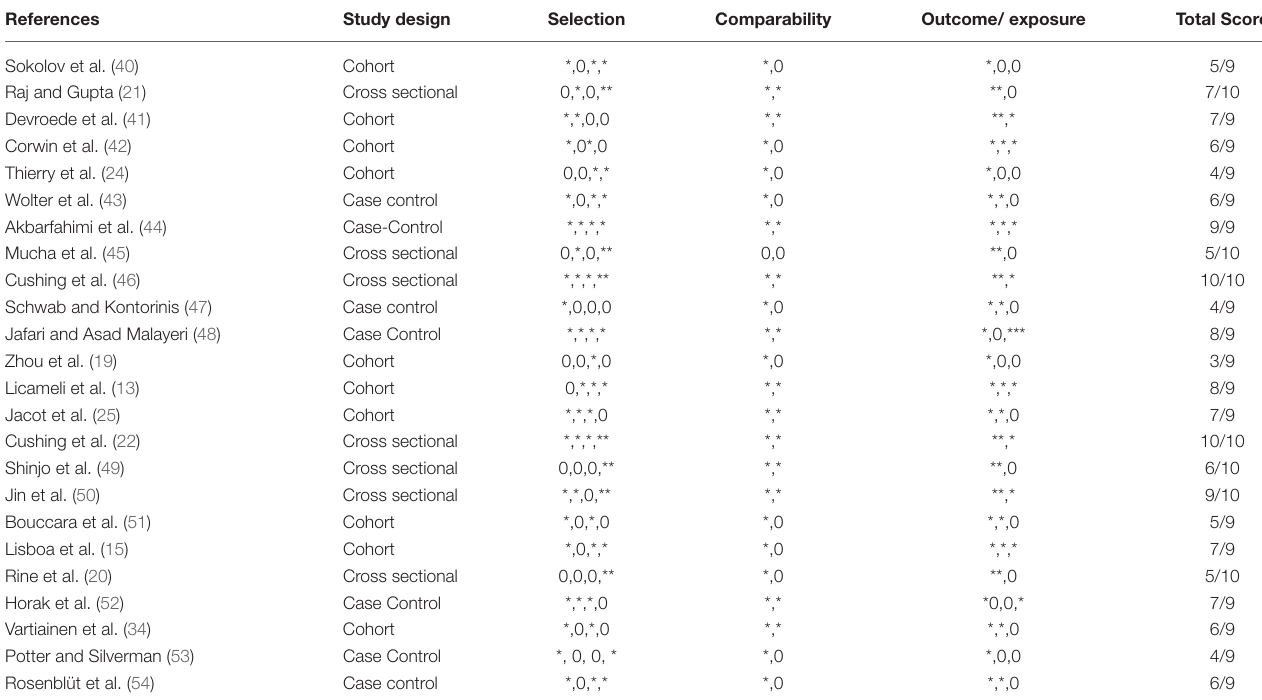
TABLE 1 | Results of quality assessment of the studies using the Newcastle—Ottawa Assessment Scale (According to, Newcastle Ottawa Quality assessment forms, observational studies can receive a maximum of 10 stars, whereas cohort and case-control studies can be attributed a maximum of 9